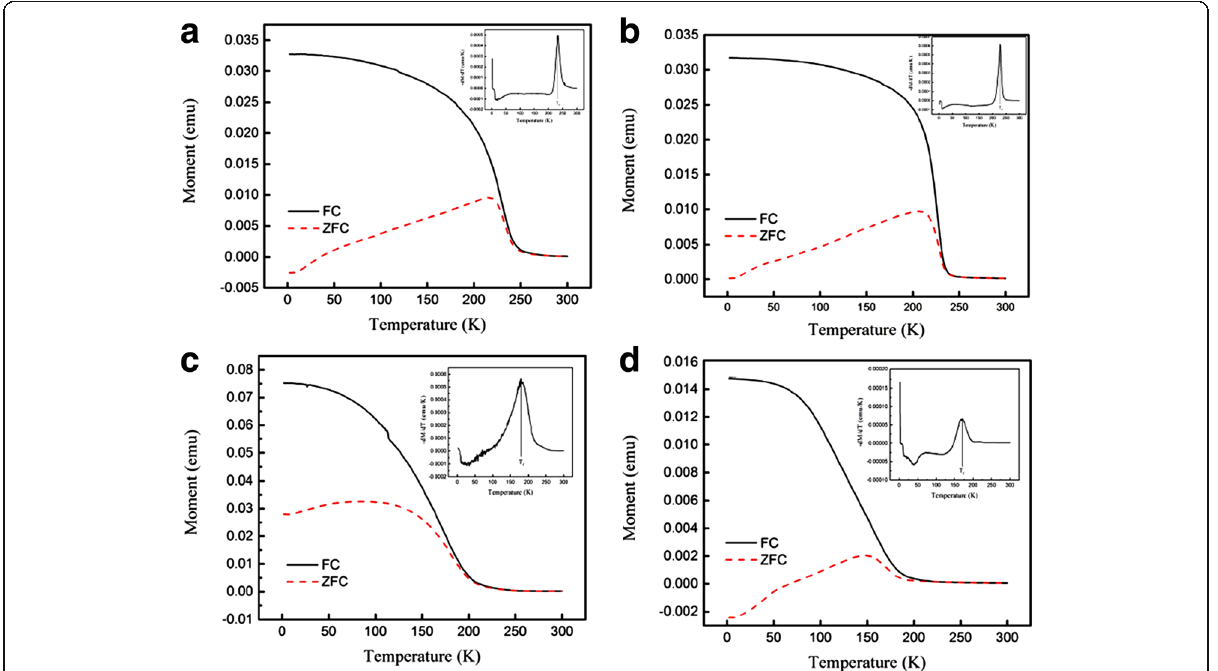
Fig. 11 Temperature dependence of the magnetizations of the (La 1 − x Pr x ) 0.67 Ca 0.33 MnO 3 nanoparticles post-annealed at 800 °C with different Pr-doping concentrations. a x = 0.1, b x = 0.2, c x = 0.3, and d x =